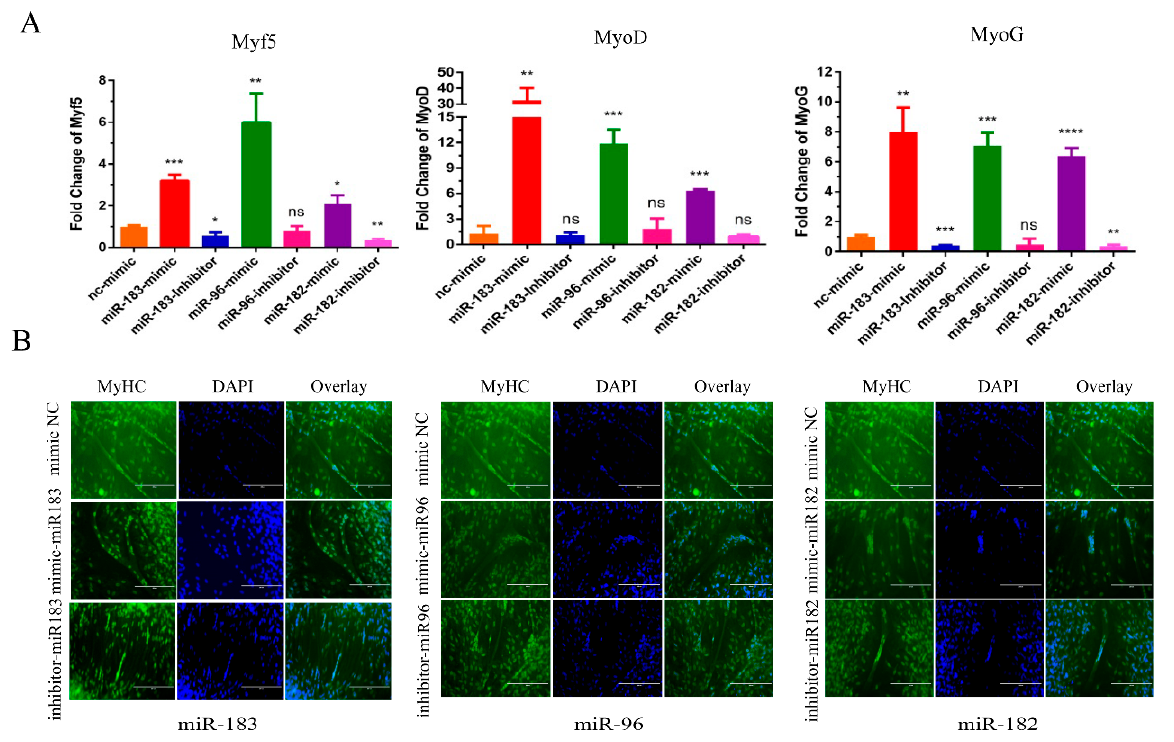
Figure 3. The miR-183/96/182 cluster promotes bovine myoblast differentiation. ( A ) The expression levels of cell differentiation genes MyoG , MyoD and Myf5 were detected by RT-qPCR. ( B ) Immunofluorescence ( MyHC ) was performed to evaluate the cell differentiation. Data are presented as the means ± SEM. NS represented no difference. * p < 0.05, ** p < 0.01, *** p < 0.001 and **** p < 0.0001.